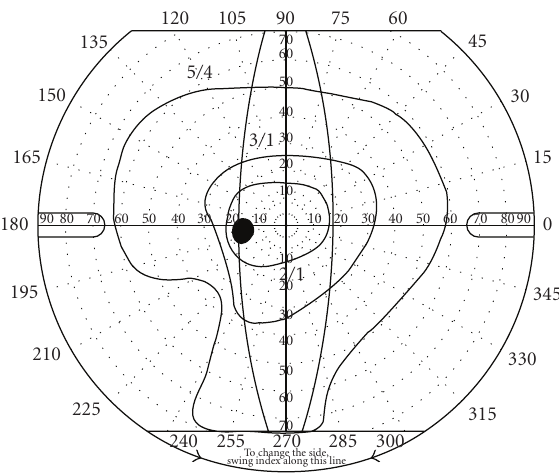
Figure 1: Goldmann visual field test two months after surgery revealed an inferotemporal visual field defect in the left eye.